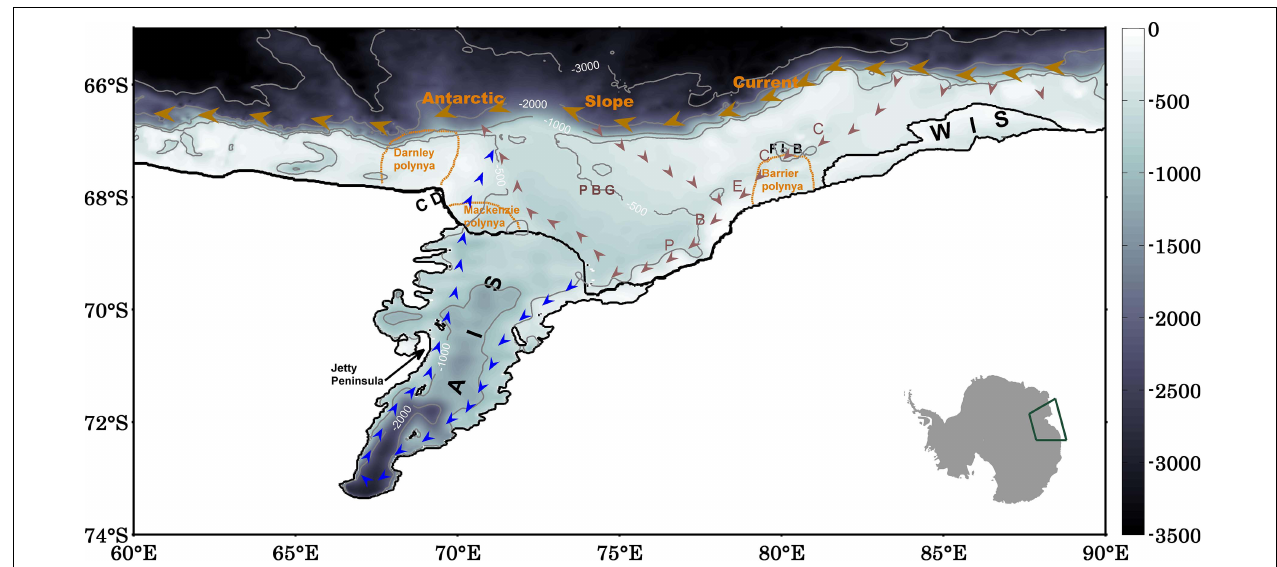
FIGURE 1 | A schematic diagram of the general ocean circulation in Prydz Bay and underneath the Amery Ice Shelf. The orange dashed lines show the locations of Darnley, Barrier and Mackenzie polynyas. The color scale shows the water column thickness in unit of m. The contours show the bathymetry. Inset: the location of Prydz Bay and the Amery Ice shelf in East